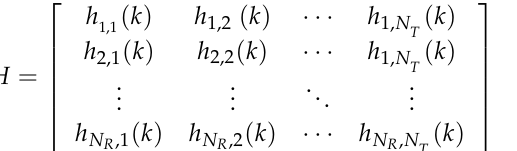
Figure 2. NxN MI-MIMO system. Figure 2. N × N MI-MIMO